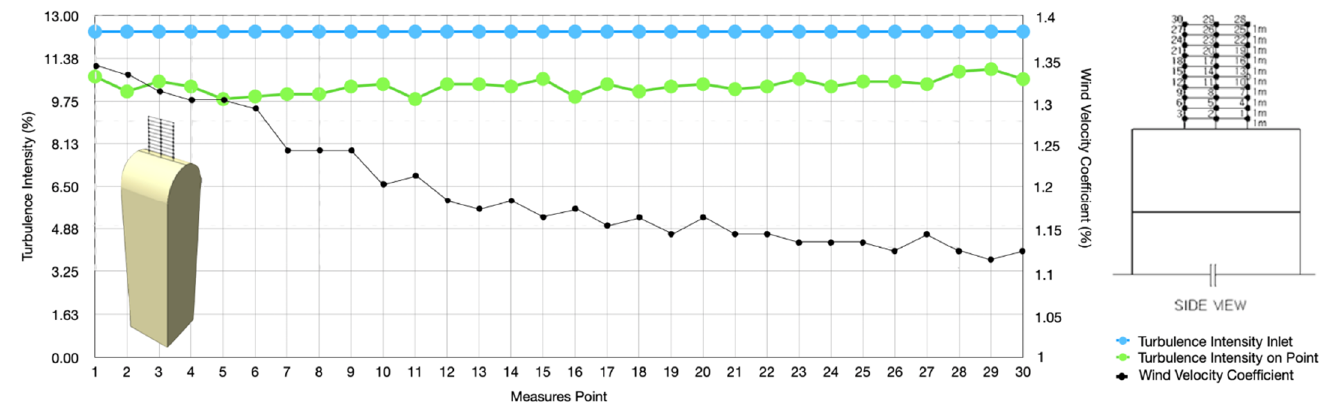
Figure 10. A wind tunnel test on building C resulted in a measurement of the velocity coefficient (VC) and turbulent intensity (TI). The ½ round shape can produce wind velocity up to 34% greater than other shapes. In this model, wind turbines should be installed in the 1 m to 2 m height above the ½ rounded shapes.